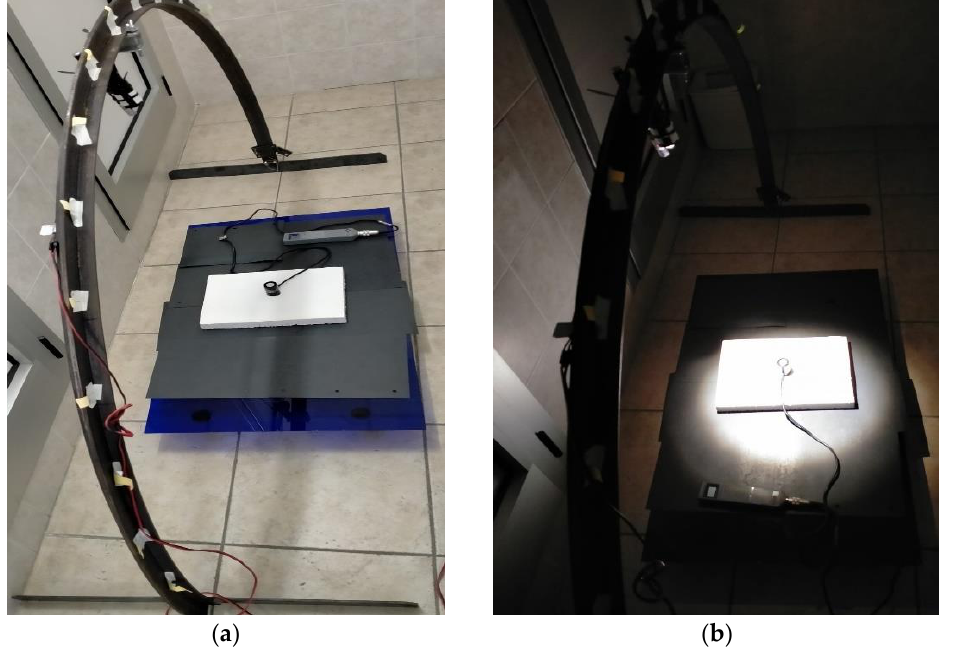
Figure 3. ( a ) Experimental facility for directivity analysis; ( b ) Operative conditions for directivity investigation of samples.